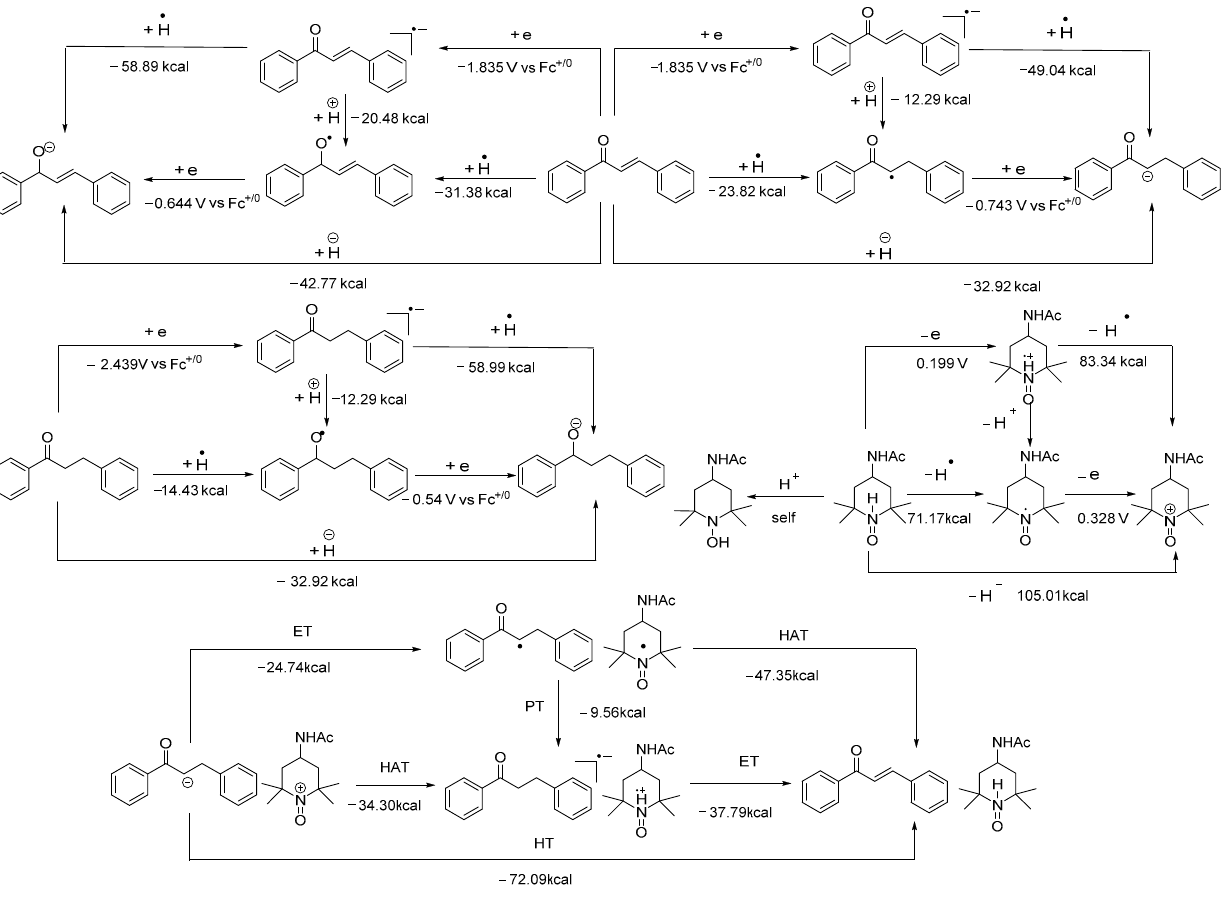
Figure 6. “Molecule ID Card” of ketones and Ac-tempo + and thermodynamic Characteristic Graph (TCG) of the hydride transfer reaction.